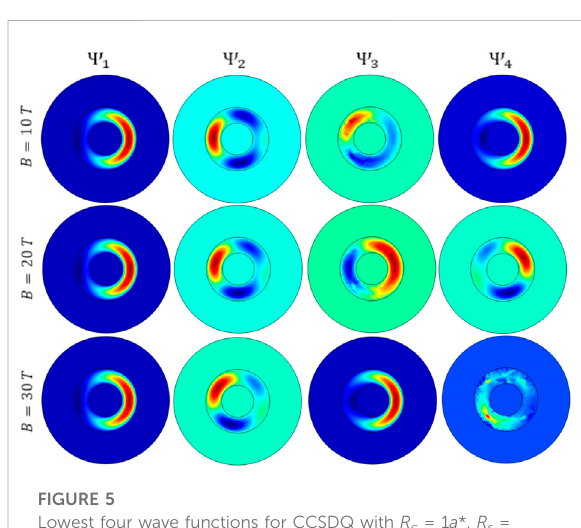
FIGURE 5 Lowest four wave functions for CCSDQ with R c = 1 a *, R s = 2 a *, H = 10 a *, for different values of B , for α R = 5 × 10 − 11 eV m